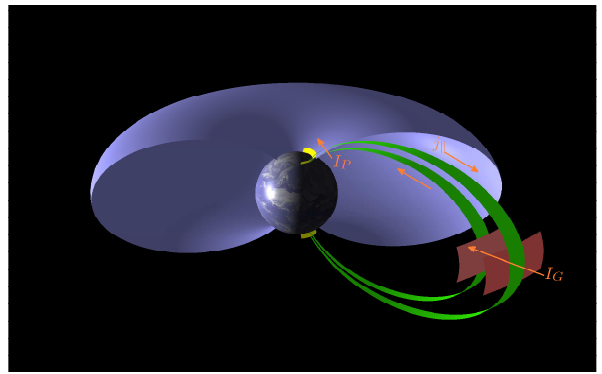
Fig. 1. Sketch of the current system above auroral features. The current I G maintained by the generator closes via field-aligned cur- rents j k and a horizontal Pedersen current I P through the load in the